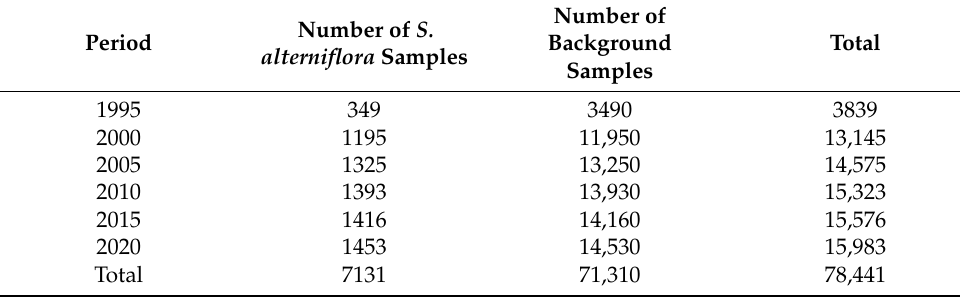
Figure 5. Spatial distribution of training samples in coastal Jiangsu in 2020. The number of samples is 15,983. The three pictures on the right are the enlarged details of the spatial distribution of the samples. The yellow box shows the coverage of the data in 2020. Table 2. Distribution of training samples of MRCNN model.